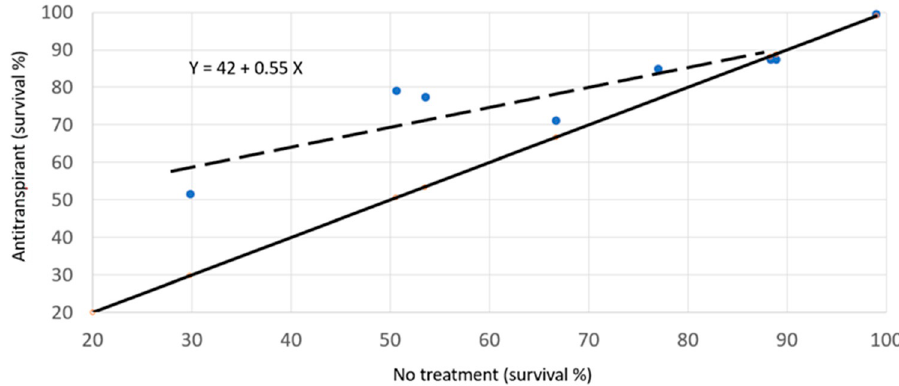
Figure 19. Survival of bareroot pine seedlings after treatment with an antitranspirant (di-1-p-menthene). Data from [132]. Seedlings with >87% survival were planted in February, and the others were planted in March. Points above the solid line represent cases where the antitranspirant increased survival. p > |t| = 0.0015 for intercept and 0.0019 for slope; R 2 = 0.82.